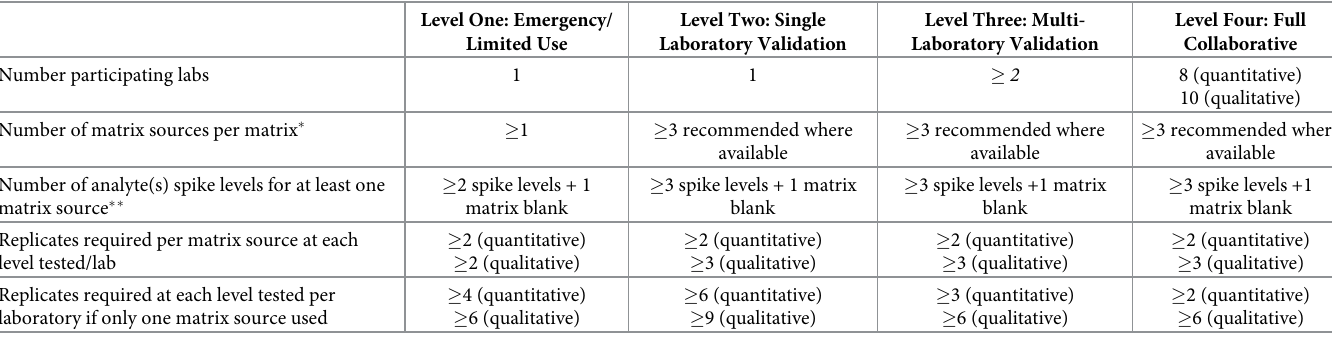
Table 3. Key validation parameter requirements for chemical